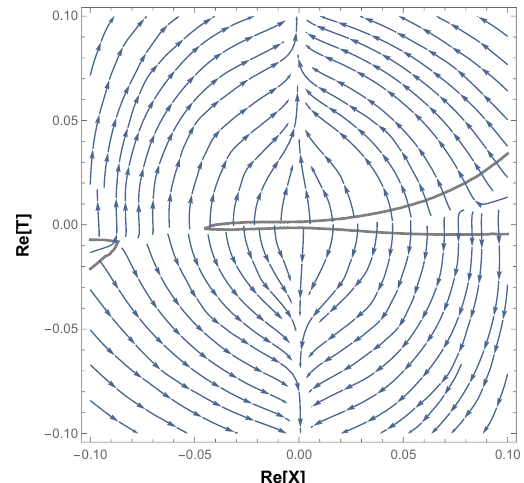
Figure 3 . This figure presents the stream-plot of the (negative) gradient of the scalar potential with RG time t = 0 . 1 for S = 114 . 92 and A = 1 , a = 0 . 1 , W 0 = − 10 − 4 , ξ UV = 1 and P = 80 near the origin of the ( X , T ) field space. The black contour shows the location where the Re S component of the gradient vanishes as well. The de Sitter critical point is slightly shifted to ( S = 114 . 9 , X = − 0 . 046 , T = − 0 . 0017 ) and is tachyonic in the T